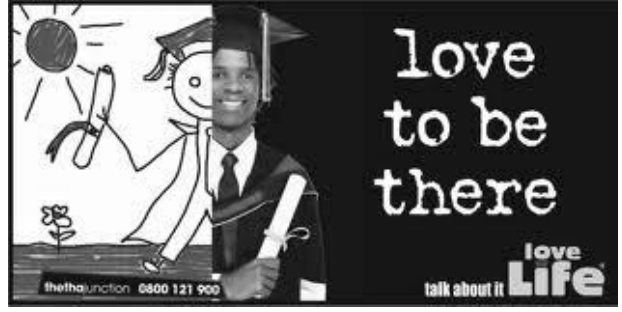
Figure 1: Typical lovelife